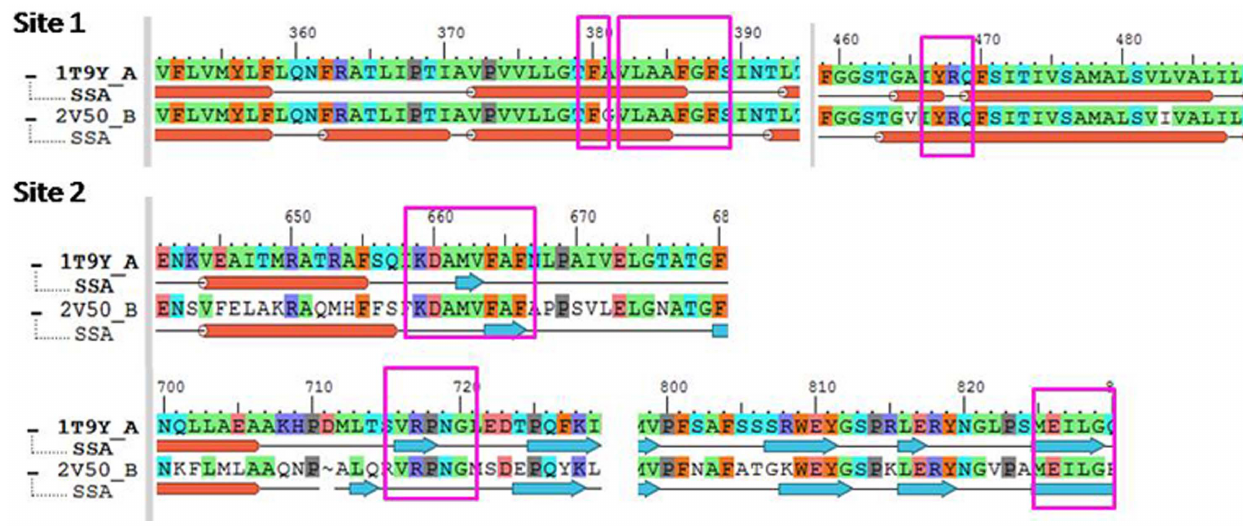
Figure 2. Alignment of protein sequences of MexB and AcrB. Sequences in box are the conserved residues in the binding site of MC-207110 in AcrB and MexB.